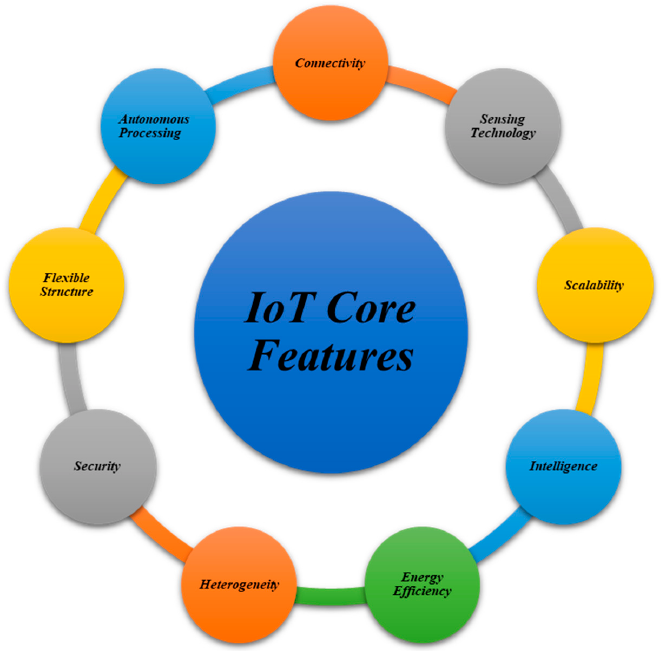
Figure 2. Key characteristics of IoT devices.